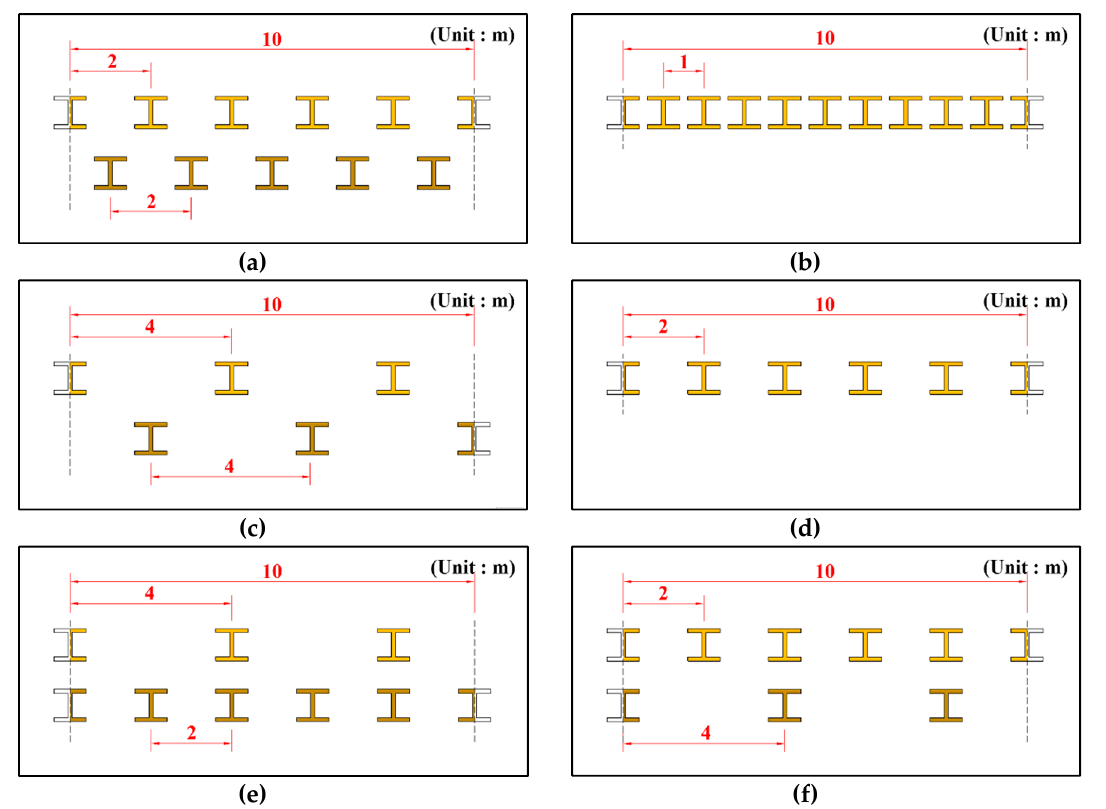
Figure 6. Analysis conditions: ( a ) D-F2-B2-10, ( b ) S-F1-10, ( c ) D-F4-B4-5, ( d ) S-F2-5, ( e ) D-F4-B2-7.5, and ( f ) D-F2-B4-7.5.